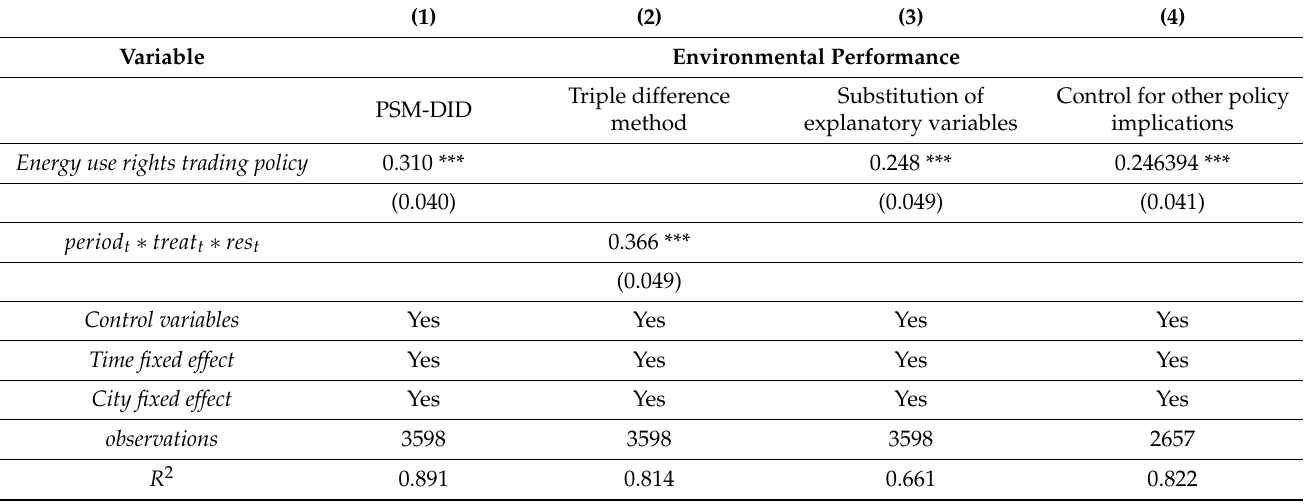
Table 7. Robustness test of energy trading policy and environmental